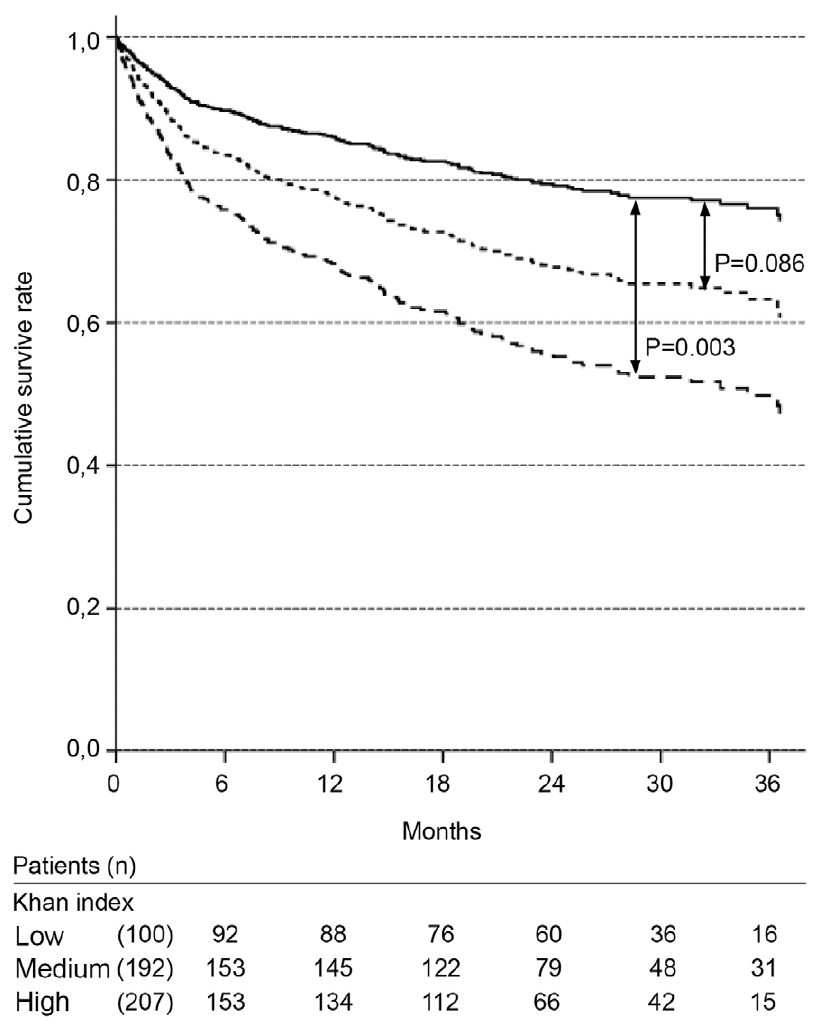
Figure 3. Cox survival curves according to Khan index. Solid line: low risk; dotted line: medium risk; dashed line: high risk. Adjusted for: gender; age; presence of cancer, heart failure, and presumed chronic kidney disease; nephrotoxic and septic etiologies.